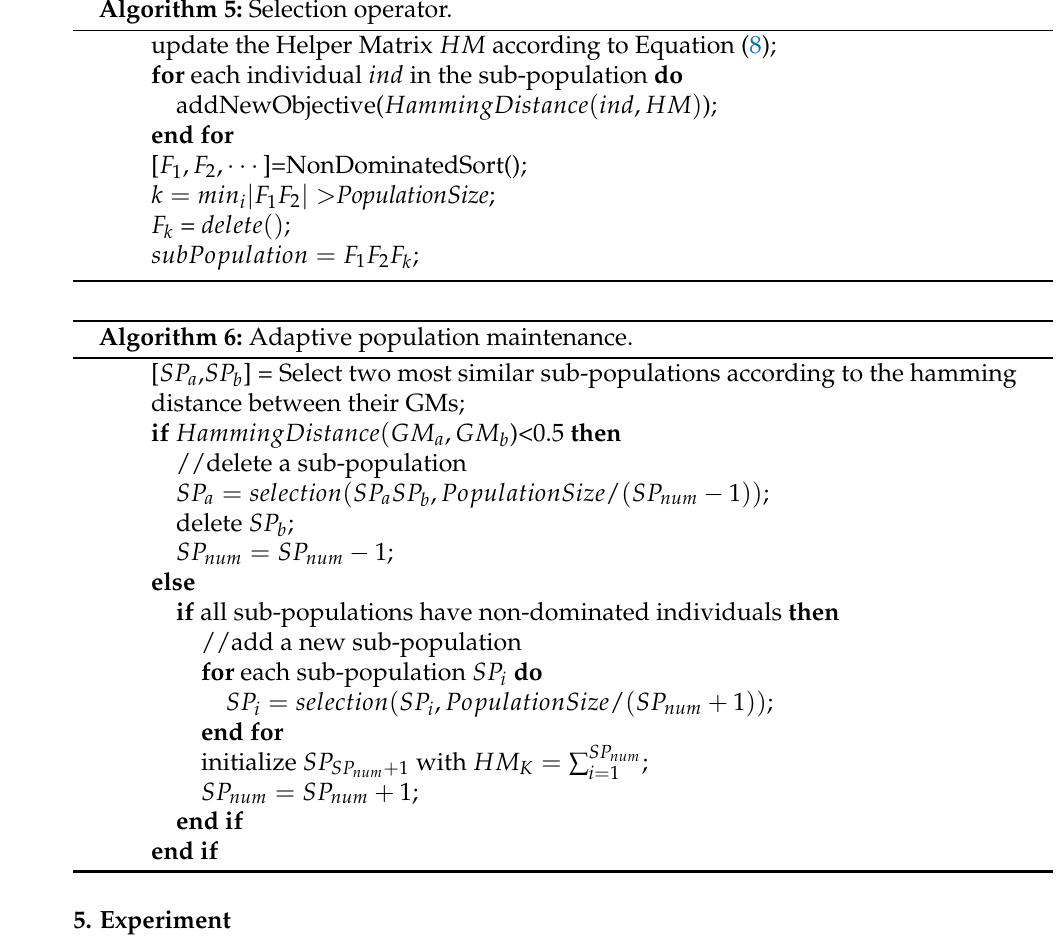
Algorithm 5: Selection operator.